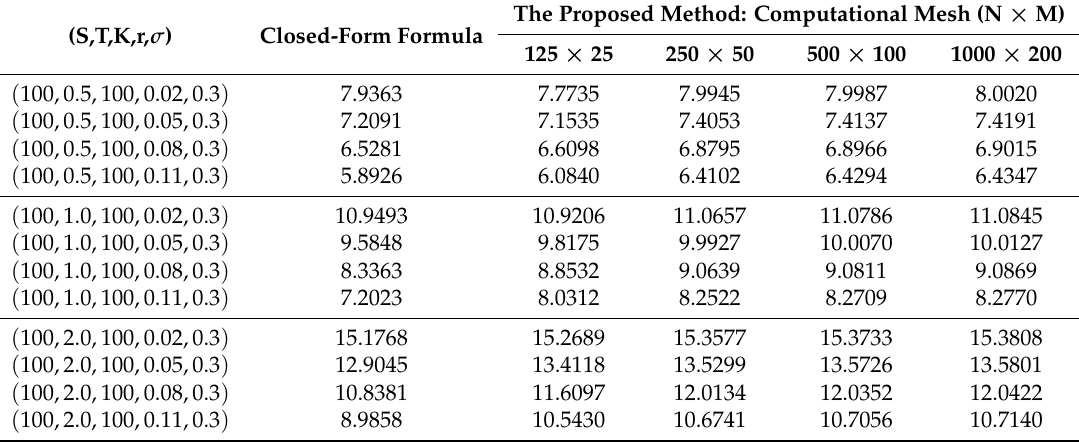
Table 3. Comparison of value of American put options with closed-form formula. (S,T,K,r, σ